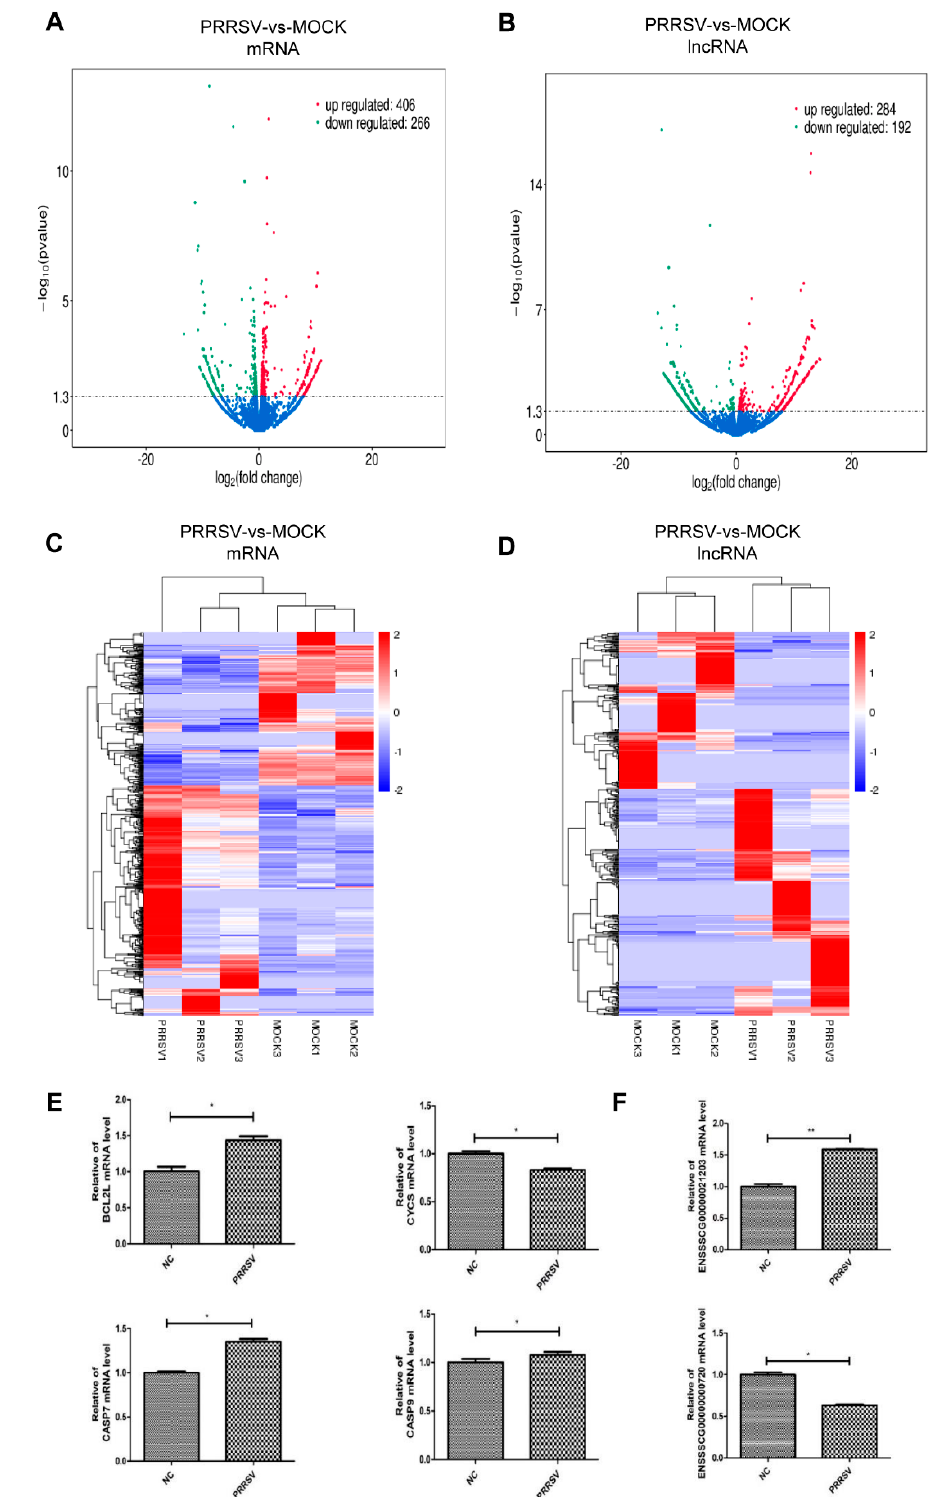
Figure 3. Expression profiles of mRNAs and lncRNAs in the PTR2 cells with PRRSV infection. Volcano plots of the differentially expressed mRNAs ( A ) and lncRNAs ( B ) transcripts. Hierarchical clustering of the expression profiles of differentially expressed mRNAs ( C ) and lncRNAs ( D ). The mRNAs expression of BCL2L1, CASP7 , and CASP9 was significantly up-regulated and the mRNA expression of CYCS was significantly down-regulated in the PRRSV-infected PTR2 cells compared to the control cells ( E ). ENSSSCG00000021203 lncRNA expression was significantly up-regulated,